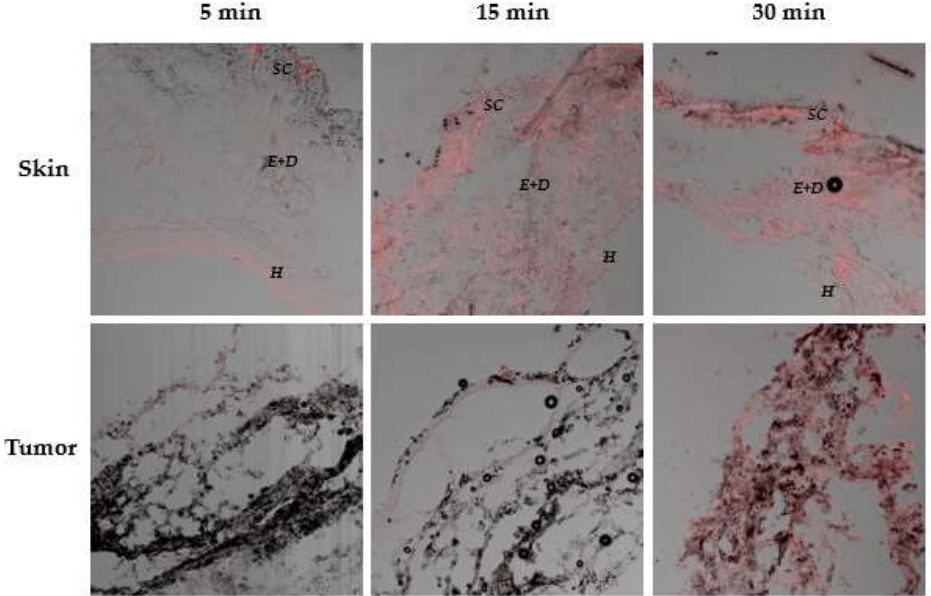
Figure 8. Representative confocal images of 20 µm thickness cryo-sections perpendicular to the skin surface and tumor samples after different times of ZnPc nanoemulsion iontophoresis (SC: stratum corneum, E + D: Epidermis and Dermis, H: hypoderm). The images represent the overlap of the light and dark field. ZnPc fluorescence was observed in the red channel (εexc = 638, εem = 640–800 nm) 20× magnification.